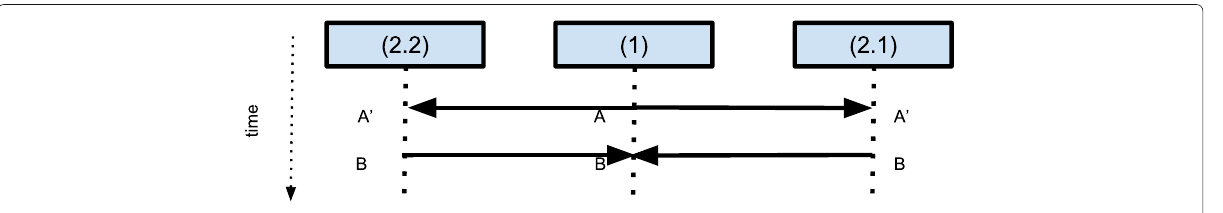
Fig. 4 Message exchange between modules of different